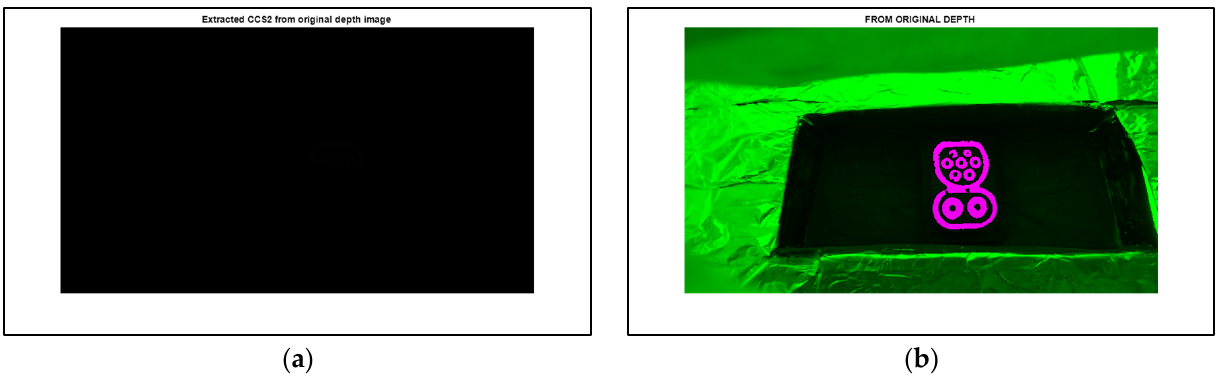
Figure 10. ( a ) Extracted CCS2 socket in 32-bit depth resolution and ( b ) extracted CCS2 socket from the original depth map converted to 8-bit depth